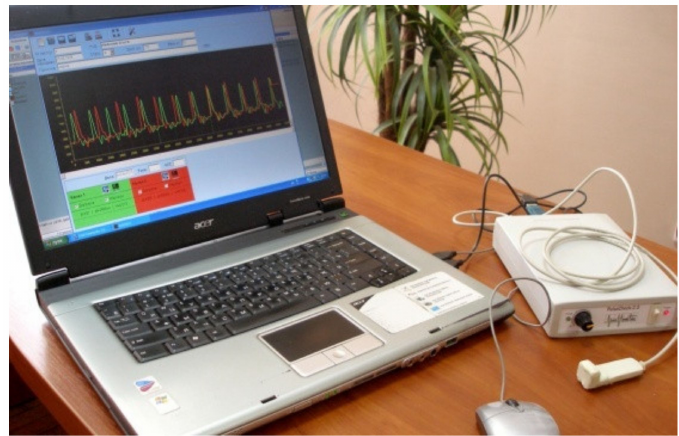
Figure 9. Optoelectronic device for diagnosing peripheral blood circulation.